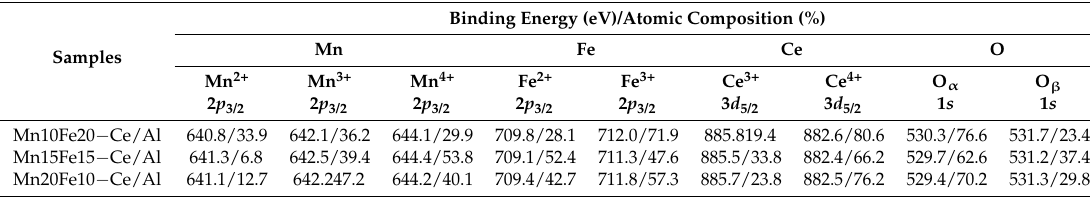
Table 2. Surface atomic compositions of the catalysts determined by